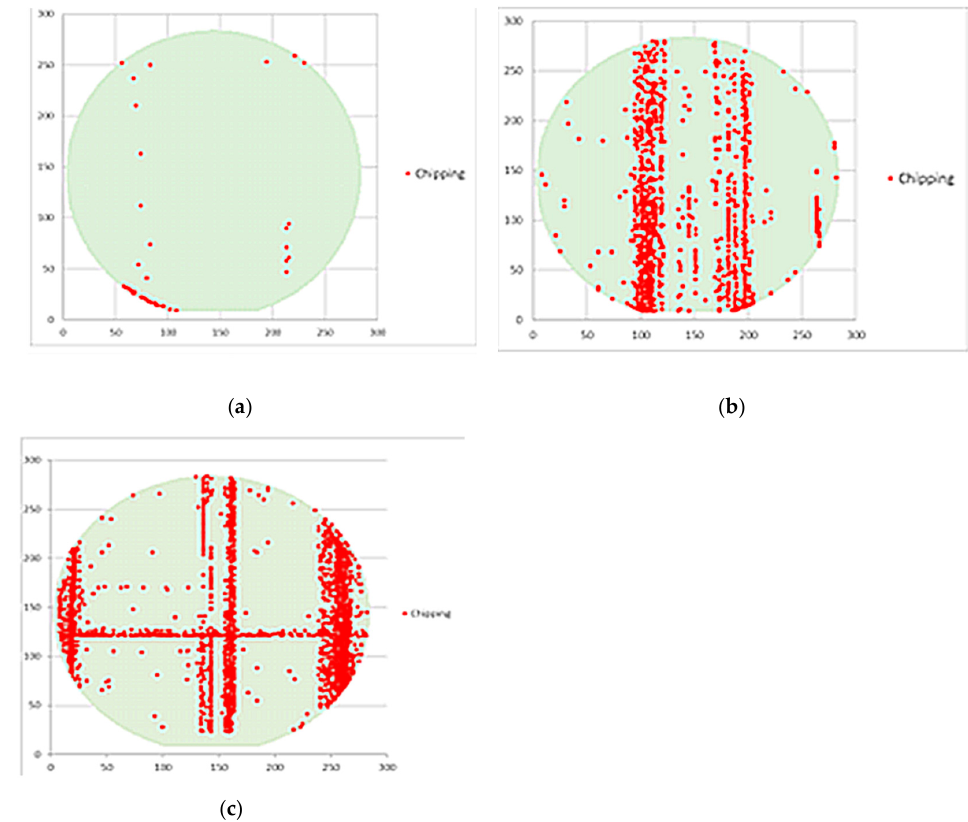
Figure 23. Wafer chipping distribution without tuning parameters where ( a ) grinding of the 1st wafer; ( b ) grinding of the 2nd wafer; ( c ) grinding of the 3rd wafer.